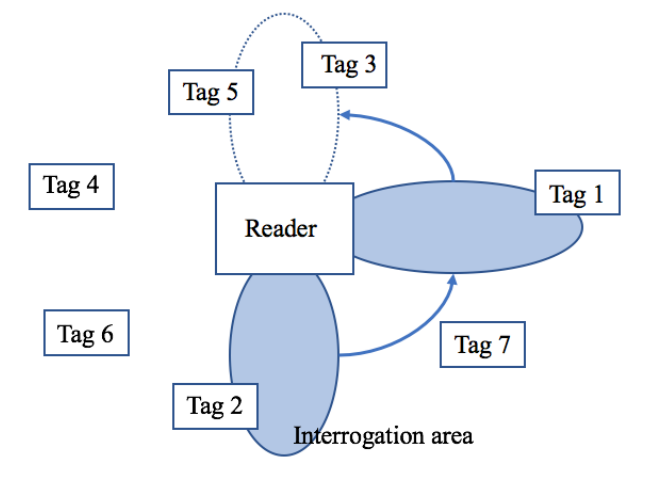
Figure 4. Space Division Multiple Access (SDMA) procedure.